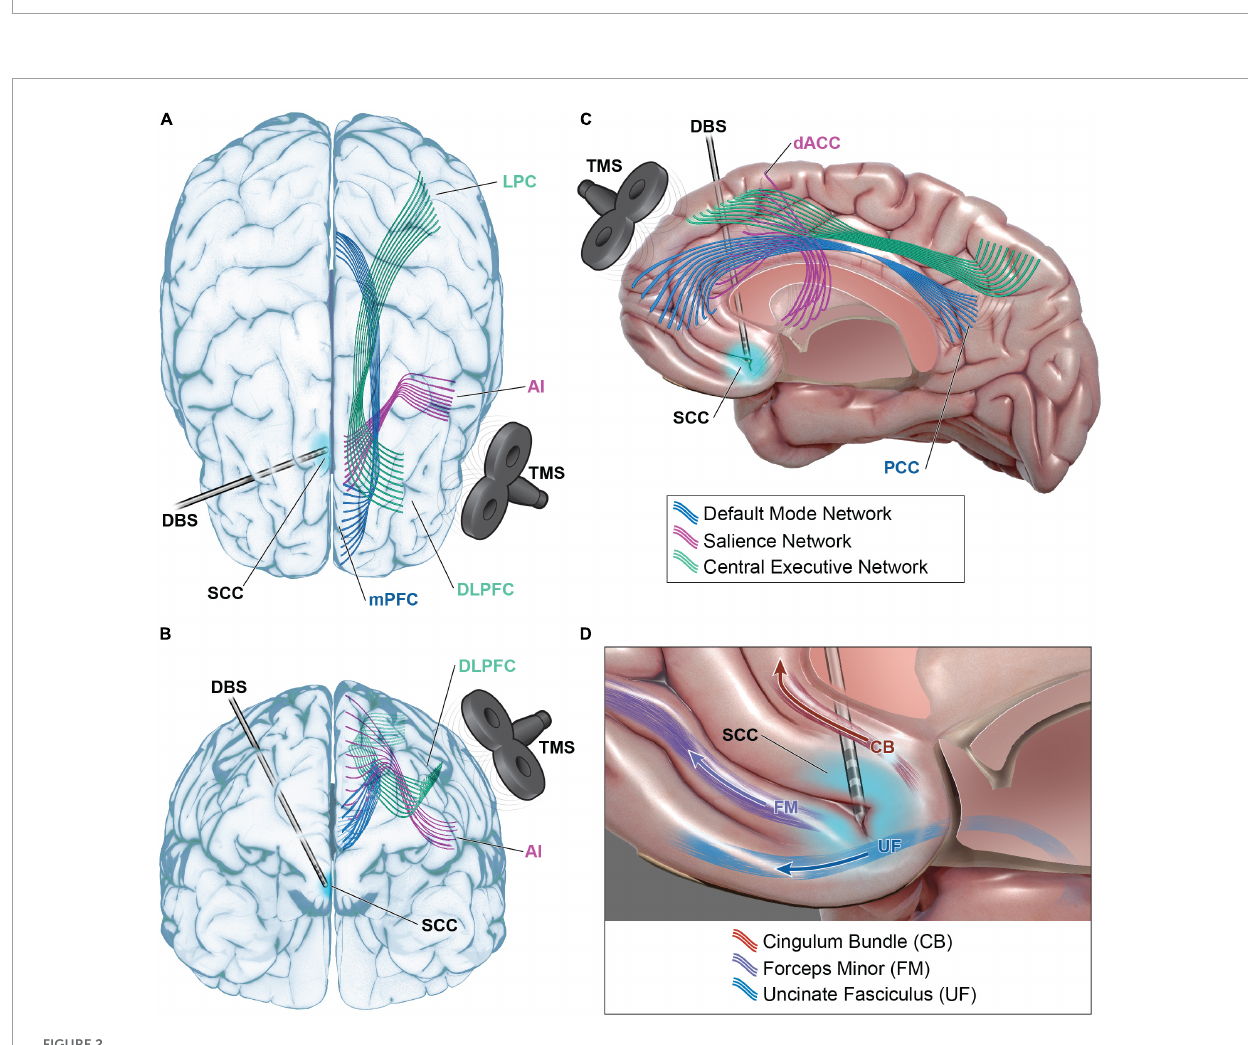
FIGURE2 Functional network modulation in TRD. Default mode network (DMN – blue), salience network (SN – purple), and central executive network (CEN – green) are accessible for modulation with transcranial magnetic stimulation (TMS) and deep brain stimulation (DBS). Dorsal lateral prefrontal cortex (DLPFC) TMS may modulate CEN via direct modulation of DLPFC and its projections to lateral parietal cortex (LPC) (A–C) . DLPFC TMS could indirectly modulate SN via functional connections with anterior cingulate cortex (ACC), anterior insula (AI), or DMN via functional connections with medial prefrontal cortex (mPFC) and posterior cingulate cortex (PCC). DBS at the intersection of subcallosal cingulate cortex (SCC), the cingulum bundle (CB), uncinate fasciculus (UF), and forceps minor (FM) may modulate SN via projections to dorsal anterior cingulate cortex (dACC) and AI (C,D) . Functional connections to DLPFC, mPFC, and PCC also present avenues for modulation of CEN and DMN. Please see Table 1 for full listing of network